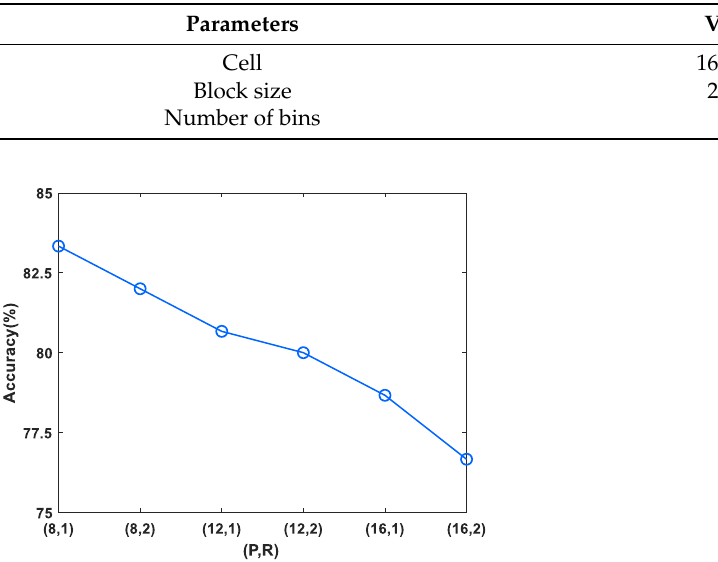
Figure 7. Performance of HOG with different parameters. Table 2. Characteristic parameters of HOG algorithm.